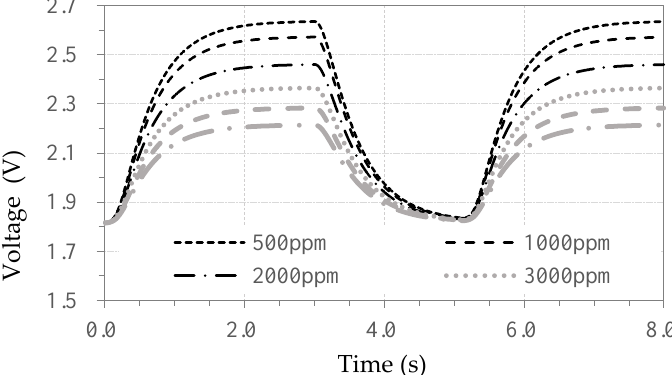
Figure 12. Simulation of working temperatures for different gas concentration.